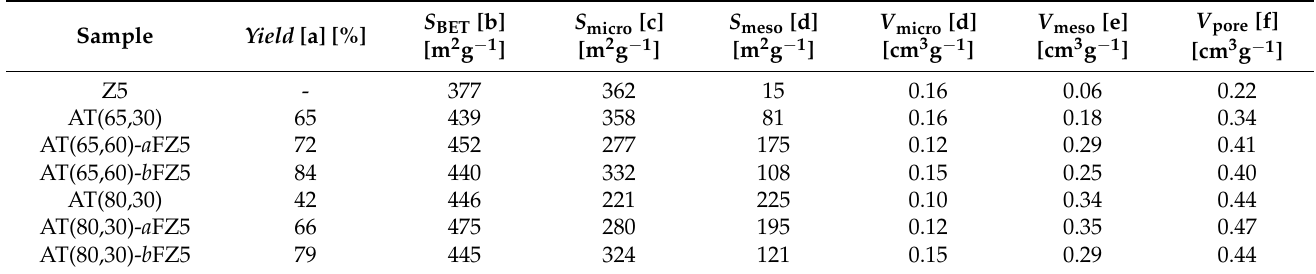
Table 1. Textural properties of pristine and fluorination-alkaline treated ZSM-5 samples. Sample